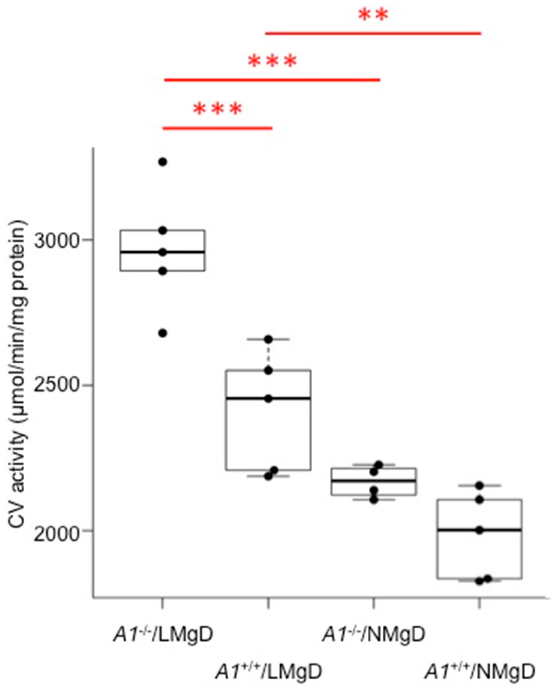
Figure A2. Post-hoc Tukey’s range test / CV. The CV activities presented as box-and-whisker plot overlaid with dot plot; dots represent raw input values for each analyzed group ( Slc41a1 − / − animals on LMgD, Slc41a1 +/+ animals on LMgD, Slc41a1 − / − animals on NMgD, and Slc41a1 +/+ animals on NMgD); ** p < 0.01, *** p < 0.001. Abbreviations: A1 , Slc41a1 ; CV, complex V; LMgD, low Mg diet; NMgD, normal Mg diet.